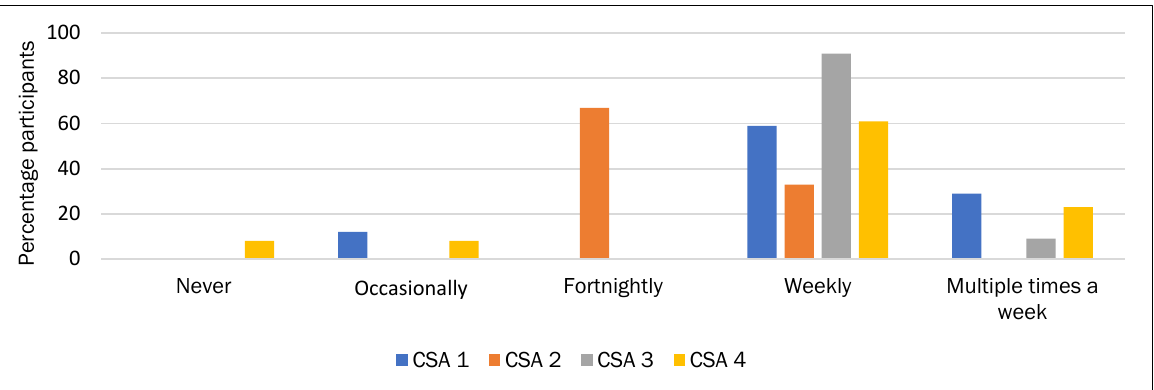
Figure 3. Frequency of CSA Contact with Members Across the Four CSAs